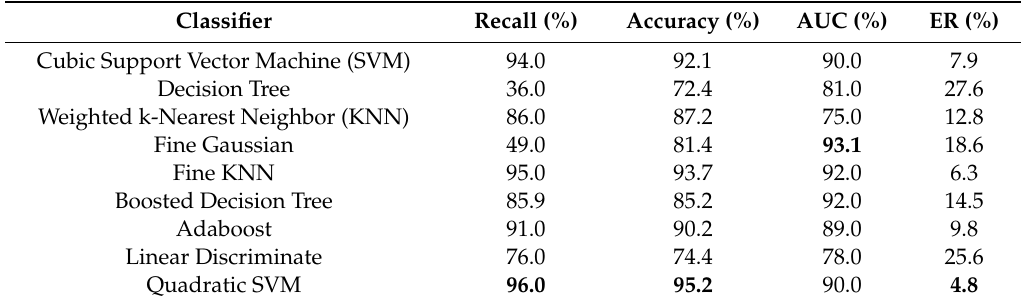
Table 3. Classification results using imbalanced dataset with SFTA features. Best values are shown in bold.